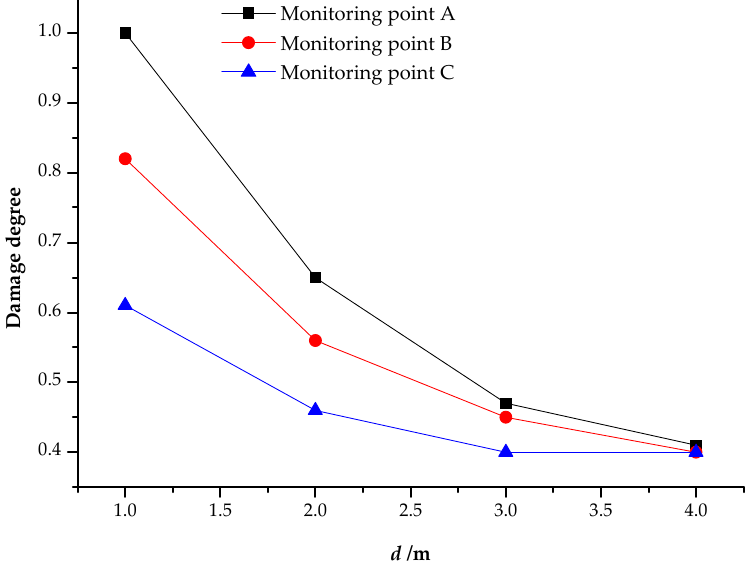
Figure 15. Damage degree variation of surrounding rock beneath the box culvert with d .